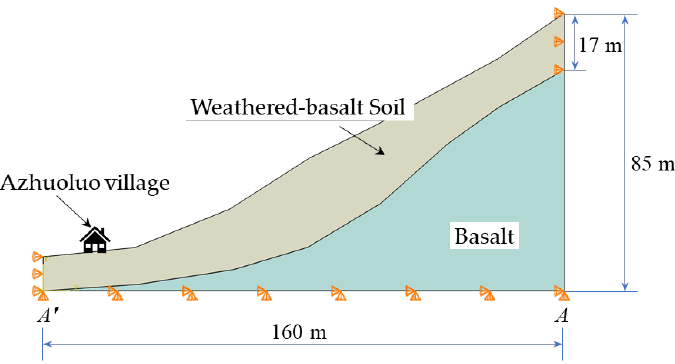
Figure 11. The numerical model of the Azhuoluo slope.